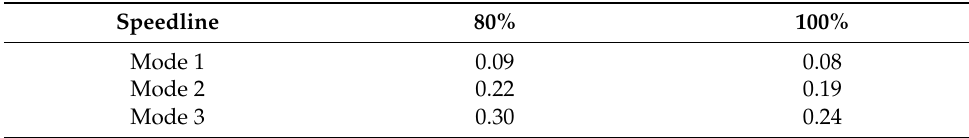
Table 4. Reduced frequency on working line